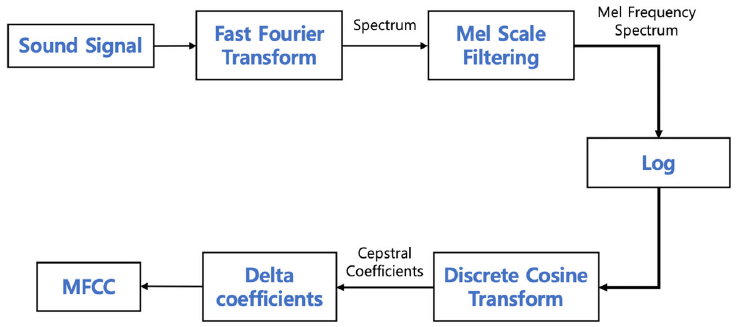
Figure 4. MFCC block diagram.